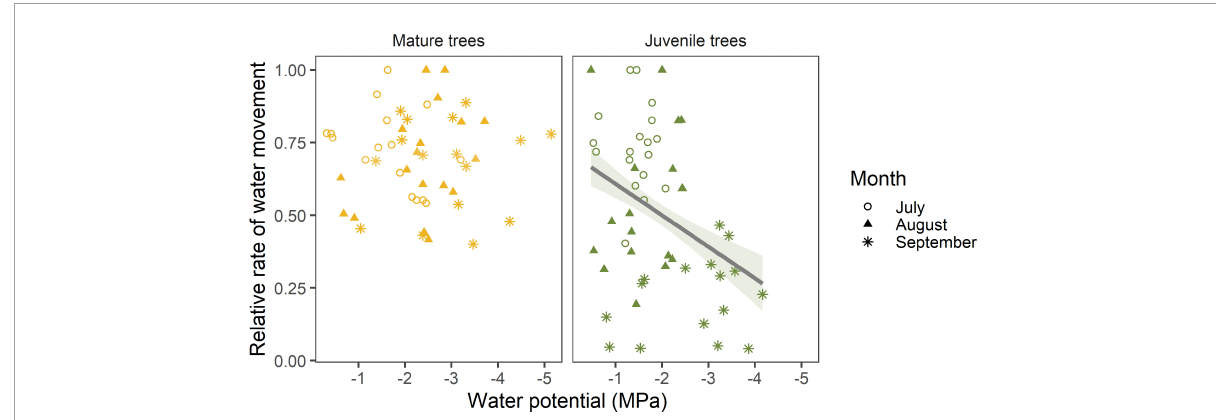
FIGURE5 Relationship between relative rate of water movement and leaf water potential for mature (not significant) and juvenile trees ( p = 0.04, R 2 = 0.41). Rate of water movement in trees is represented by rate of stomatal conductance in saplings and rate of sap flux in mature trees (Bryant et al., 2022). The solid line represents a significant relationship at a 95% confidence interval (shaded). Data were combined and species included as a random effect ( n = 18 trees per age group per